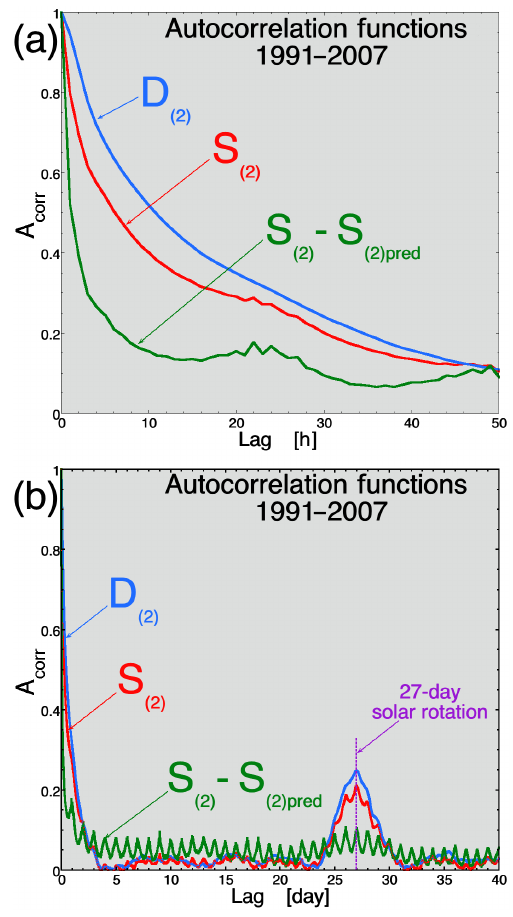
Figure 3. The autocorrelation functions for the system scalar S ( 1 ) (red), the driver scalar D ( 1 ) (blue), and the unaccounted-for vari- ance E ( 1 ) E ( 1 ) pred (green) are plotted. In panel (a) the plot extends to 50h and in panel (b) the plot extends to 40d.